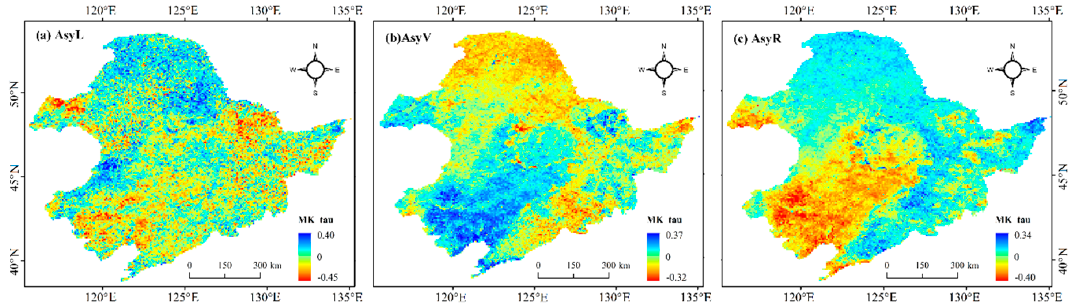
Figure 5. Spatial distribution of long-term trends of vegetation asymmetries (mk tau).